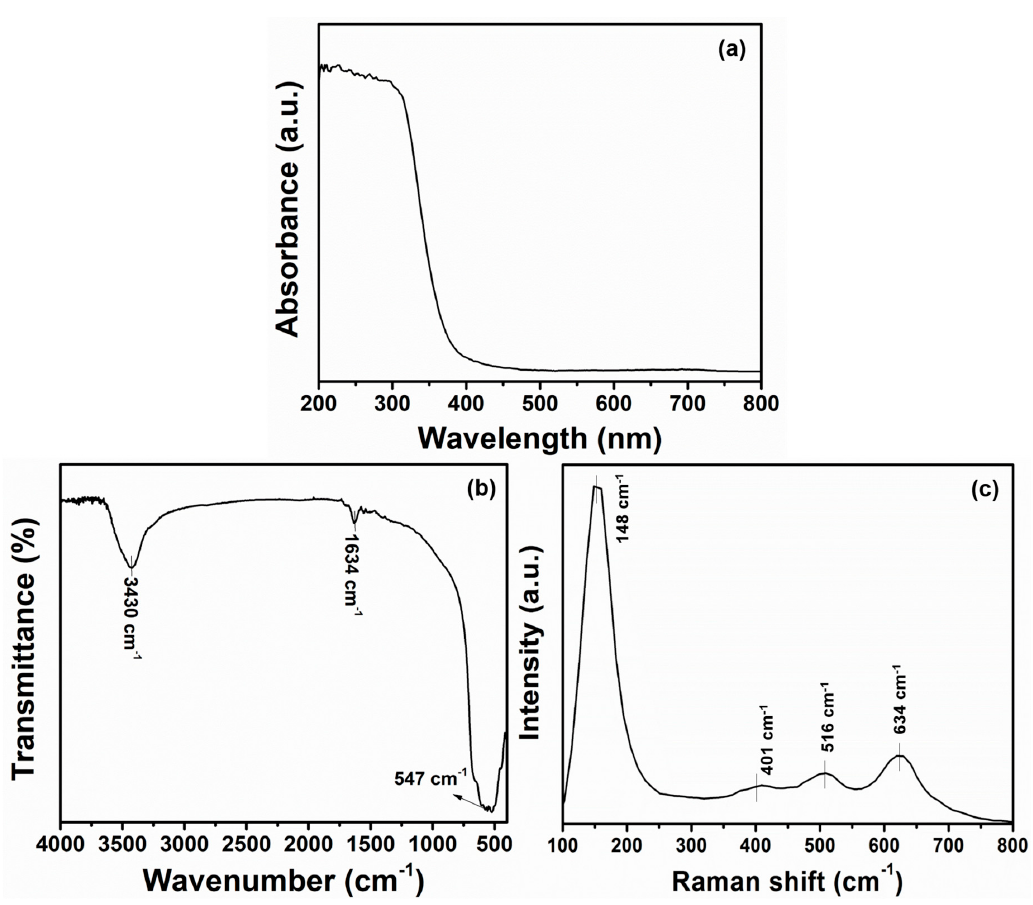
Figure 4. Typical ( a ) UV–Visible, ( b ) FTIR, and ( c ) Raman-scattering spectroscopy of synthesized TiO 2 nanoflowers.